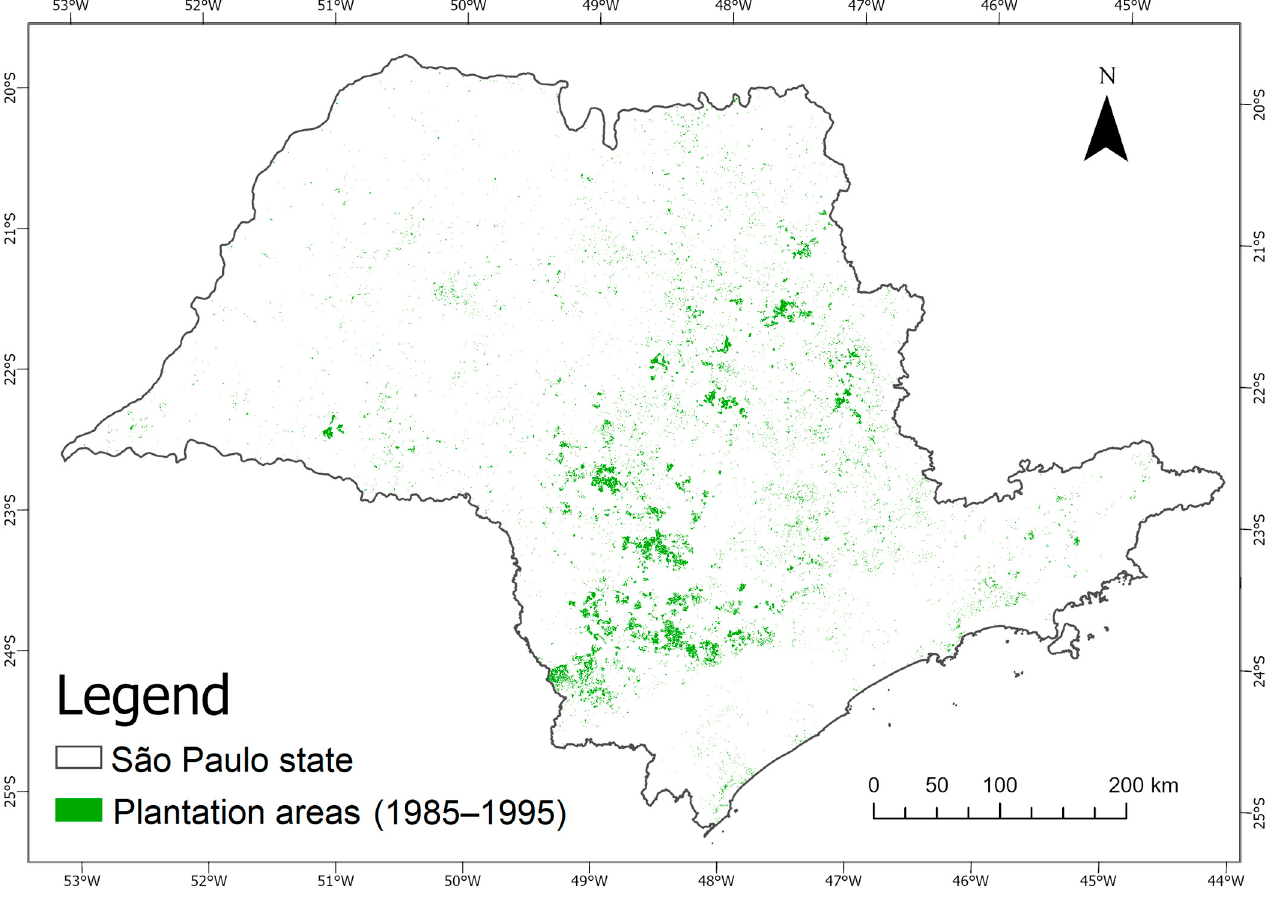
Figure 5. Classification of plantation areas in the study area during the study period (1985–1995), based on the Landsat TM annual mosaics.